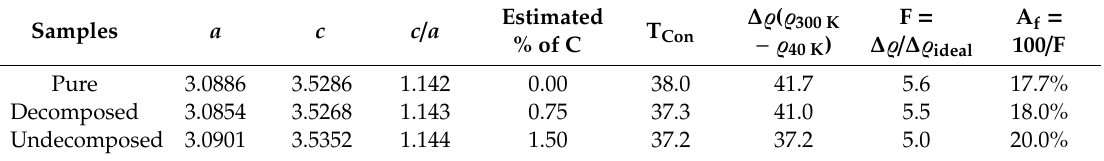
Table 1. The lattice parameters, estimated C (%), and e ff ective grain connectivity of the samples.